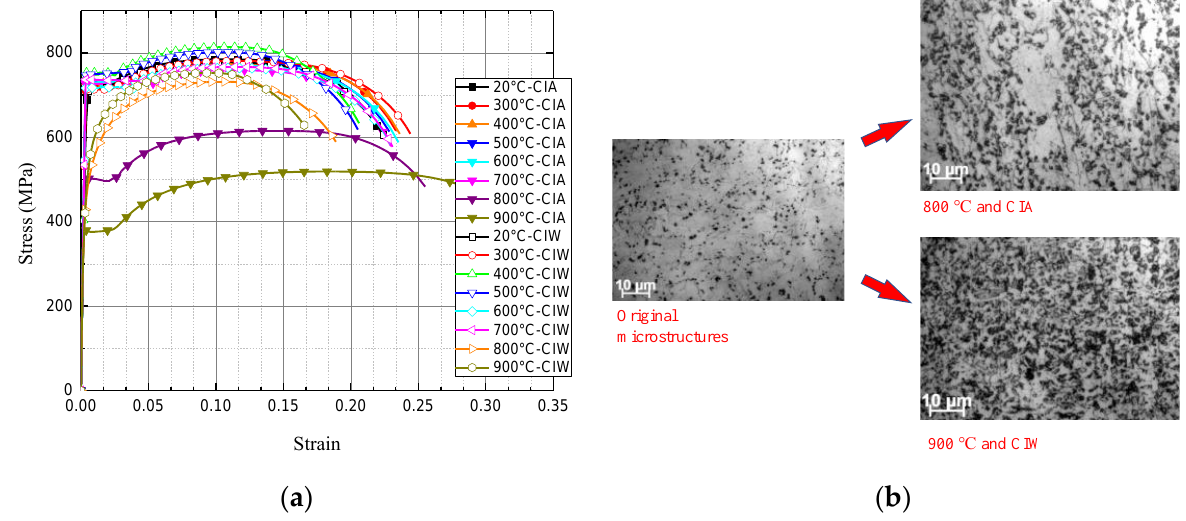
Figure 4. Results of the material test. ( a ) strain-stress curve; ( b ) microstructures.